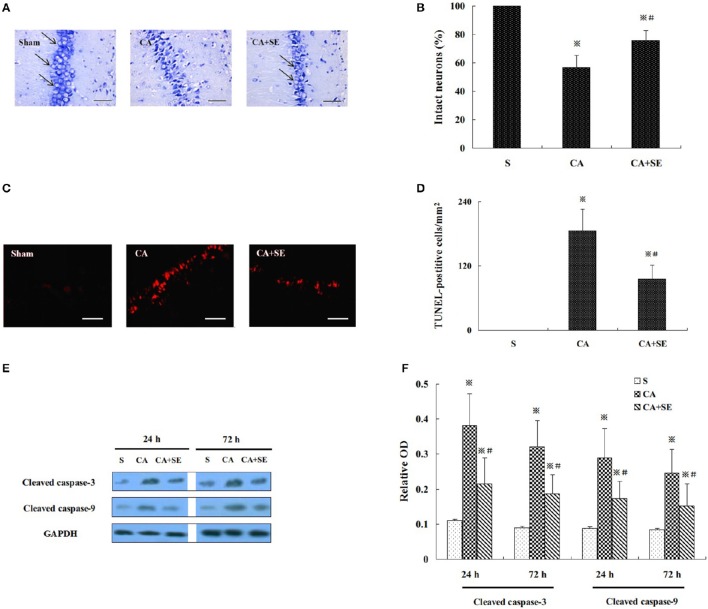
Sevoflurane treament ameliorate cerebral ischemic injury in CA model. (A) Nissl staining showed the pathological changes in CA1 region; Magnification 400×, Bar = 100 μm. (B) The percentage of intact neurons in CA1 region after 72 h reperfusion in different groups (n = 6). (C) TUNEL staining was performed on the CA1 region. Magnification is 400×. Scale bar = 100 μm. (D) The statistical analysis of apoptotic neurons in CA1 region of different group (n = 6). (E) Western blot analysis showed cleaved caspase-3 and -9 expression in the hippocampus of animals treated with or without sevoflurane. (F) Quantification of cleaved caspase-3 and -9 expression at 24 and 72 h after global cerebral ischemia. Data are expressed as mean ± S.D. n = 6–8 rats for each group. ※P < 0.05 vs. the sham group; #P < 0.05 vs. the CA group.